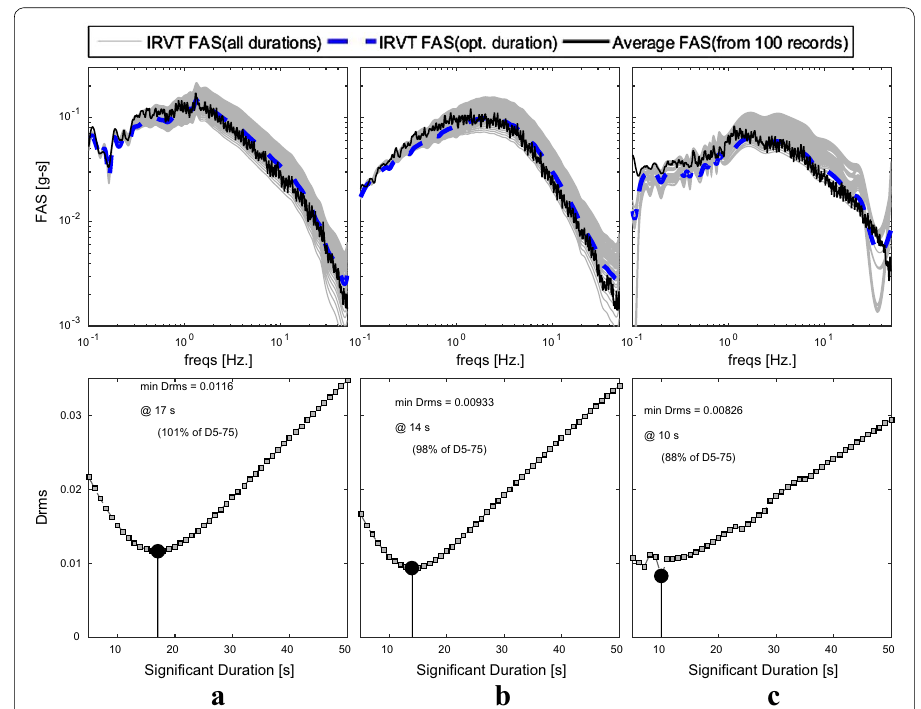
Fig. 3 Estimation of the optimal duration for IRVT: Top figures show the IRVT FAS obtained for different dura‑ tions and bottom figures show their corresponding D rms when compared against the average FAS from the set of 100 spectrum compatible series time‑series. Left to right: results corresponding to the NRC, NGA and NUC target